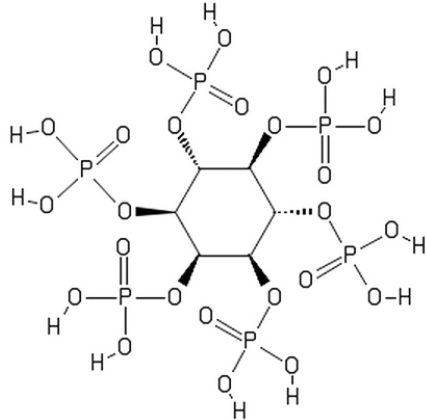
Figure 1. Structure of phytic acid